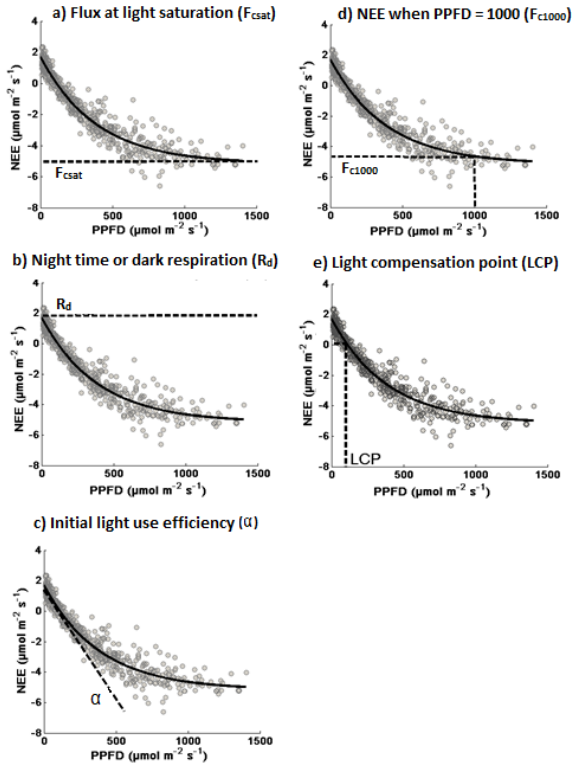
Figure B1. Parameterization of LRC (Eq. 1). Continuous lines show the shape of the light response curves while broken lines illustrate parameters of the light response curves: (a) flux at light saturation; (b) dark respiration (c) initial light use efficiency; (d) NEE when PPFD = 1000µmolm − 2 s − 1 and (e) light compensation point.